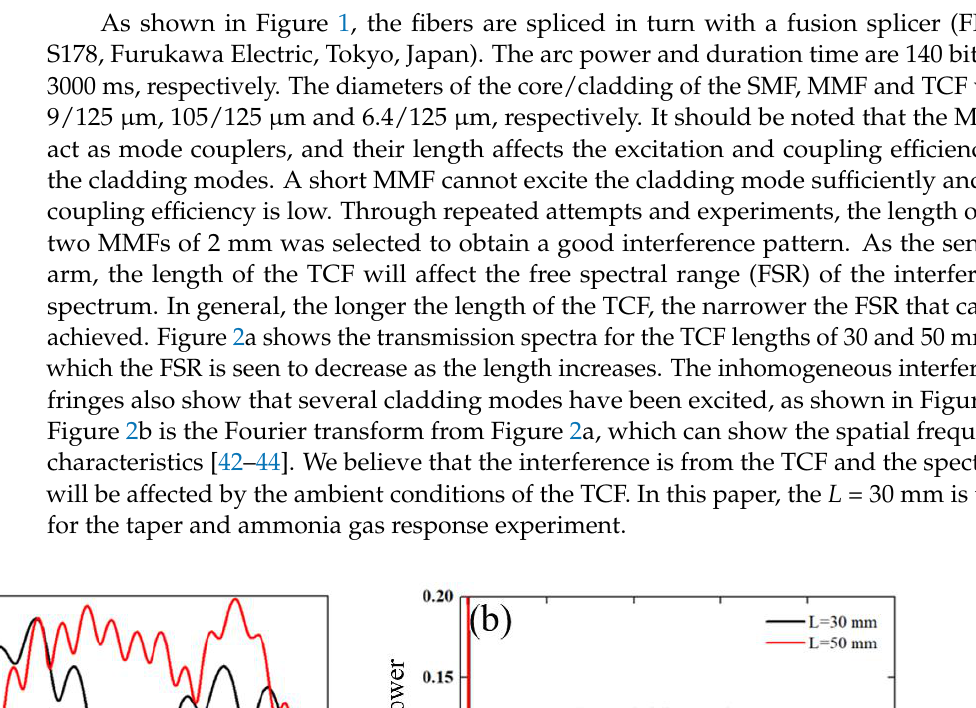
Figure 3. ( a ) SEM image of the tapered-TCF. ( b ) Transmission spectrum of the MZI sensor with and without tapering. 3.2. Preparation and Coating of Graphene Oxide The process of coating GO onto the tapered-TCF is shown in Figure 4. First, a 0.08 mg/mL GO dispersion (XF020, Nanjing XFNANO Materials Tech. Co., Ltd., Nanjing, China) was centrifuged at 10,000 RPM for 15 min to create GO sheets with a size larger than 500 nm. Second, the fiber was cleaned with alcohol several times, and the sensing area was immersed in a sufficient-sized droplet of GO dispersion and was naturally evap- orated for 24 h at temperature of 25 °C. As a result, GO adhered to the surface of the fiber, seen in the SEM image (Figure 5). We observe that the GO layer is uniformly attached to the surface of the tapered-TCF and a large number of undulating folds are formed simul- taneously. The undulating folds increase the effective surface area of the GO exposed to the gas, which is advantageous for absorption. It should be noted that the thickness of the GO film can be adjusted by controlling the concentration of the GO solution and the im- mersion time. For comparison, we measured the transmission spectra of the sensor with and without GO (Figure 6). There are no obvious changes except for the contrast, and the GO coating has not affected the interference properties of the sensor.